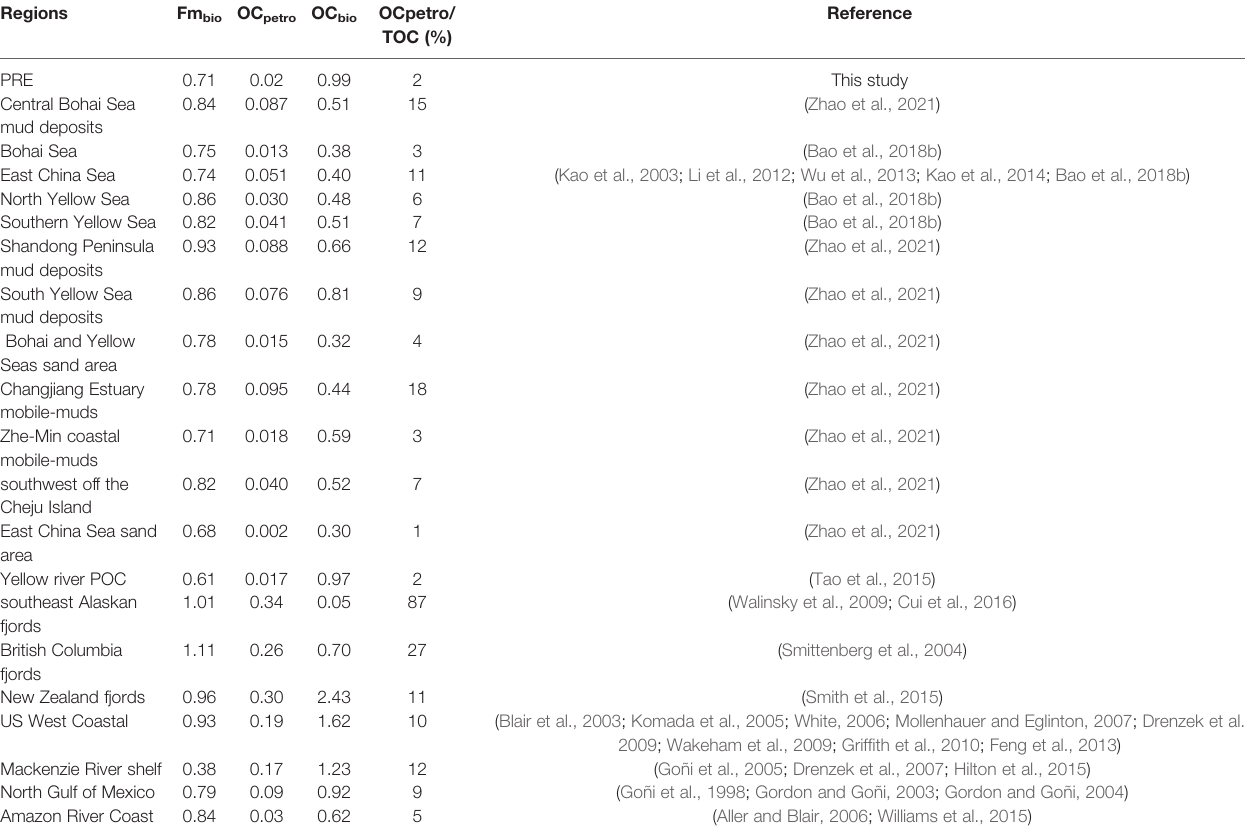
TABLE 4 | Comparison of Fm bio, OC petro , OC bio and OC petro /TOC values in the sediments between the PRE and other studies.